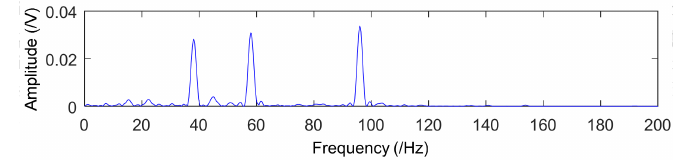
Figure 14. Diagonal slice spectrum after using multiscale local projection for noise reduction.